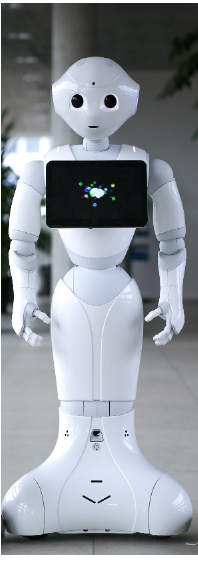
Figure 4. The Pepper